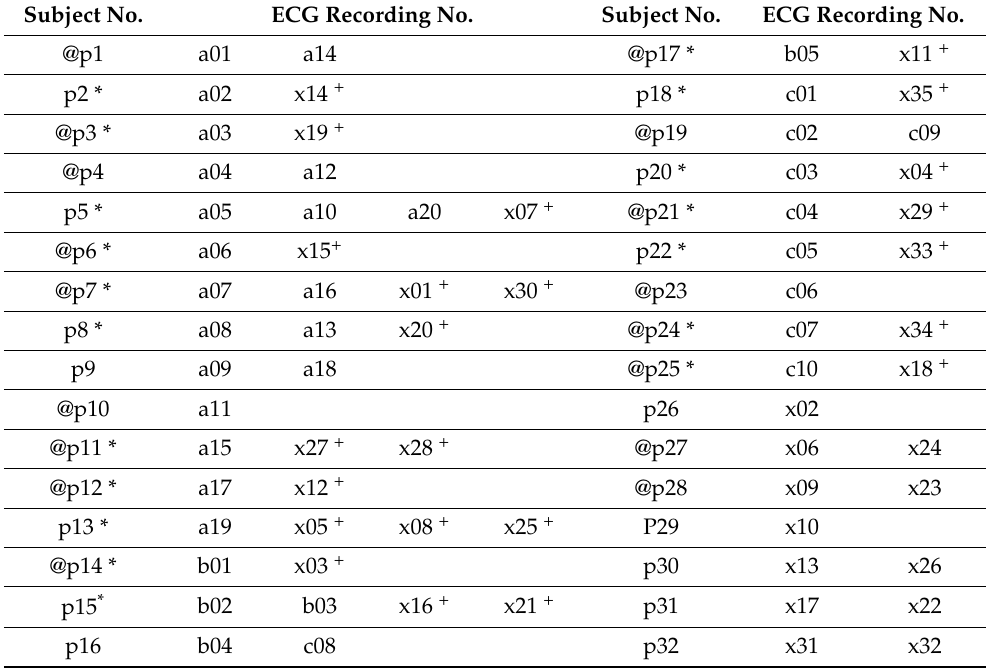
Table 1. Summary of the ECG recordings for each study subject in the MIT PhysioNet Apnea- ECG